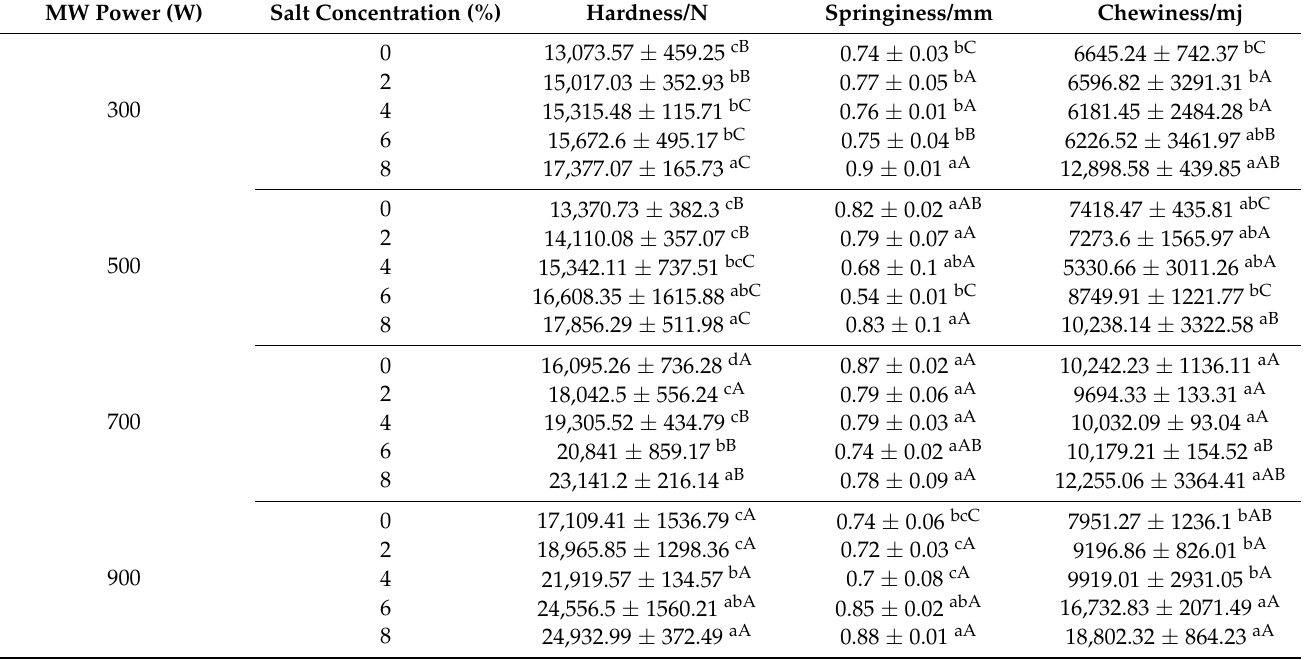
Table 3. Effects of salt concentrations and MW powers on texture of dried shrimps after MW